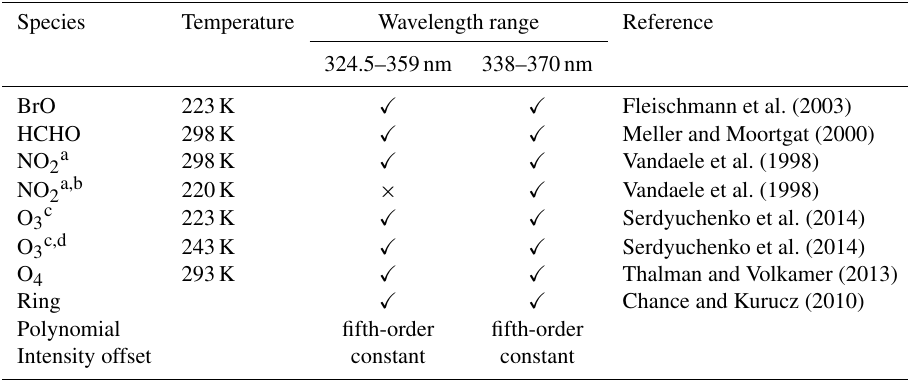
Figure 2. An example of the DOAS retrieval of NO 2 and HCHO DSCDs from a MAX-DOAS spectrum taken on 4 November 2016 at 10:02LT (local time) with viewing elevation angle of α = 2 ◦ . The left panels show the DOAS fit in the wavelength range 338–370nm, while the right panels show the DOAS fit in the wavelength range 324.5–359nm. Table 1. The DOAS retrieval settings for different wavelength